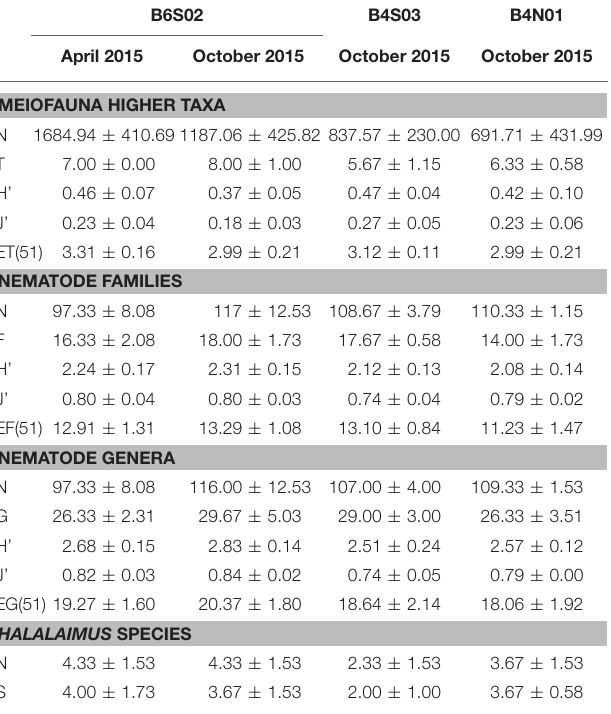
TABLE 3 | Average ( ± SD) counts and values of diversity indices for meiofauna (higher) taxa, nematode families, nematode genera, and Halalaimus species